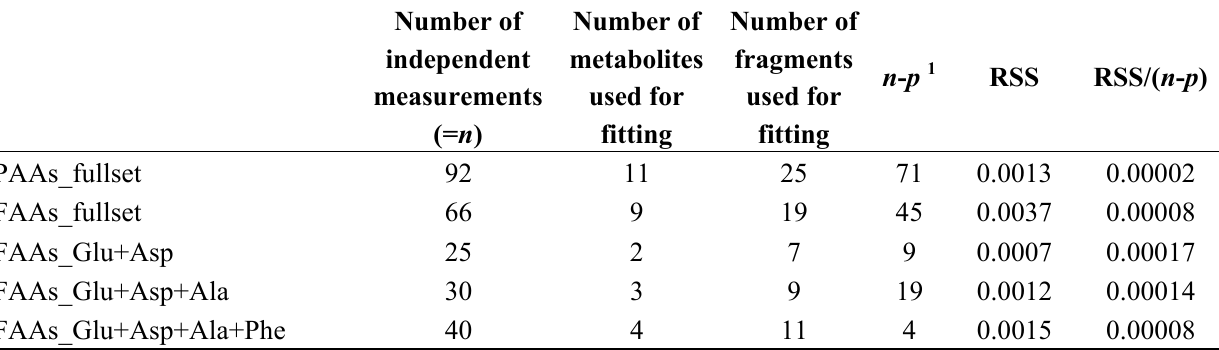
Table 1. Data points used for metabolic flux analysis and residual sum of squares (RSS) of best-fitted results.